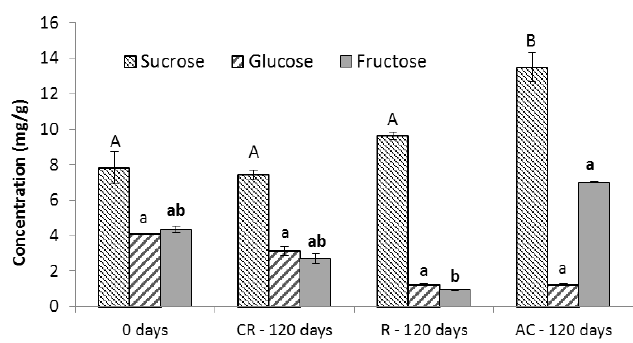
Fig. 3: Changes in the contents (mg / g dry weight) of sucrose, glucose and fructose in seeds of A. squamosa L. from Castilla-Tolima. without storage (0 days) and stored for 120 days under ambient conditions, AC (19 °C and RH = 60%), cool room CR (4 °C and RH = 79%) and refrigeration R (10 °C and RH = 79%). n = 3. The ANOVA showed a significant effect of storage on the glucose (P ≤ 0.05), fructose and sucrose (P ≤ 0.01) concentrations. Means with different letters indi- cate significant differences according to the Tukey test (P ≤